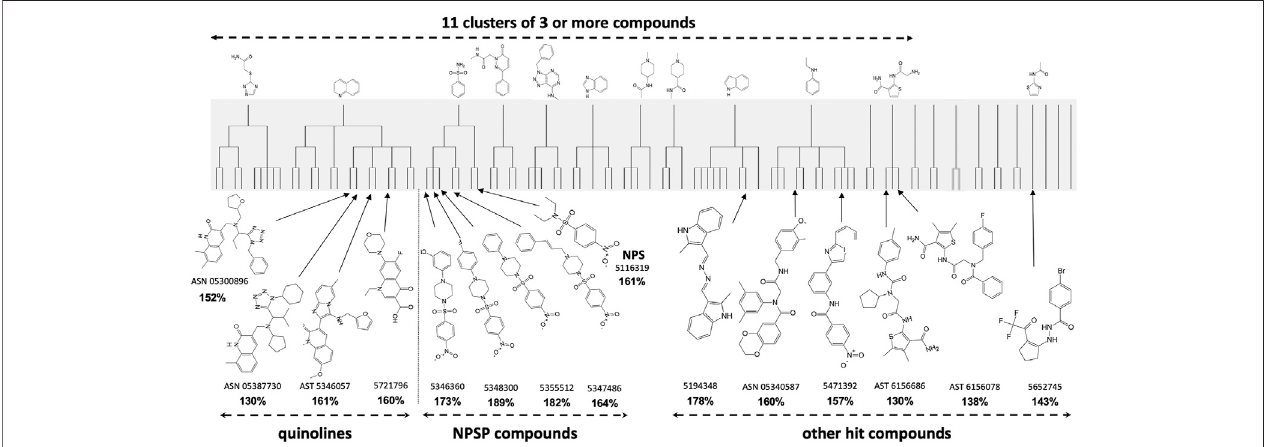
FIGURE 1 | Maximal Common Substructure analysis of in vitro HTS “ hits ” (shaded) showing clusters of at least three active compounds. The 15 validated hits cherry-pickedfor invivo testingareshownalongwiththeextenttowhichtheymitigated2 Gy invitro radiationcytotoxicity(inbold)comparedtocontrolstreatedwith2 Gy alone (100%).